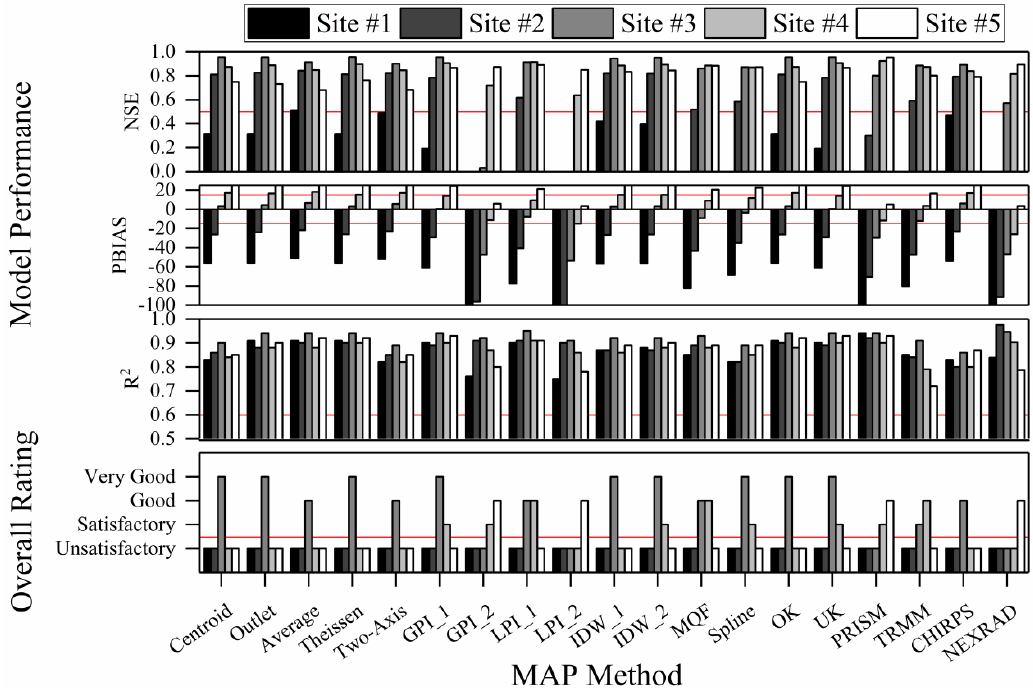
Figure 2. Mean areal precipitation (MAP) input effects on uncalibrated hydrological model performance criteria and overall performance ratings for SWAT model simulated annual streamflow at five gauging sites (gray-scale columns) located in the Hinkson Creek Watershed, Missouri, USA. The red lines show “Satisfactory” model performance thresholds. PBIAS values smaller than − 100 are not shown.